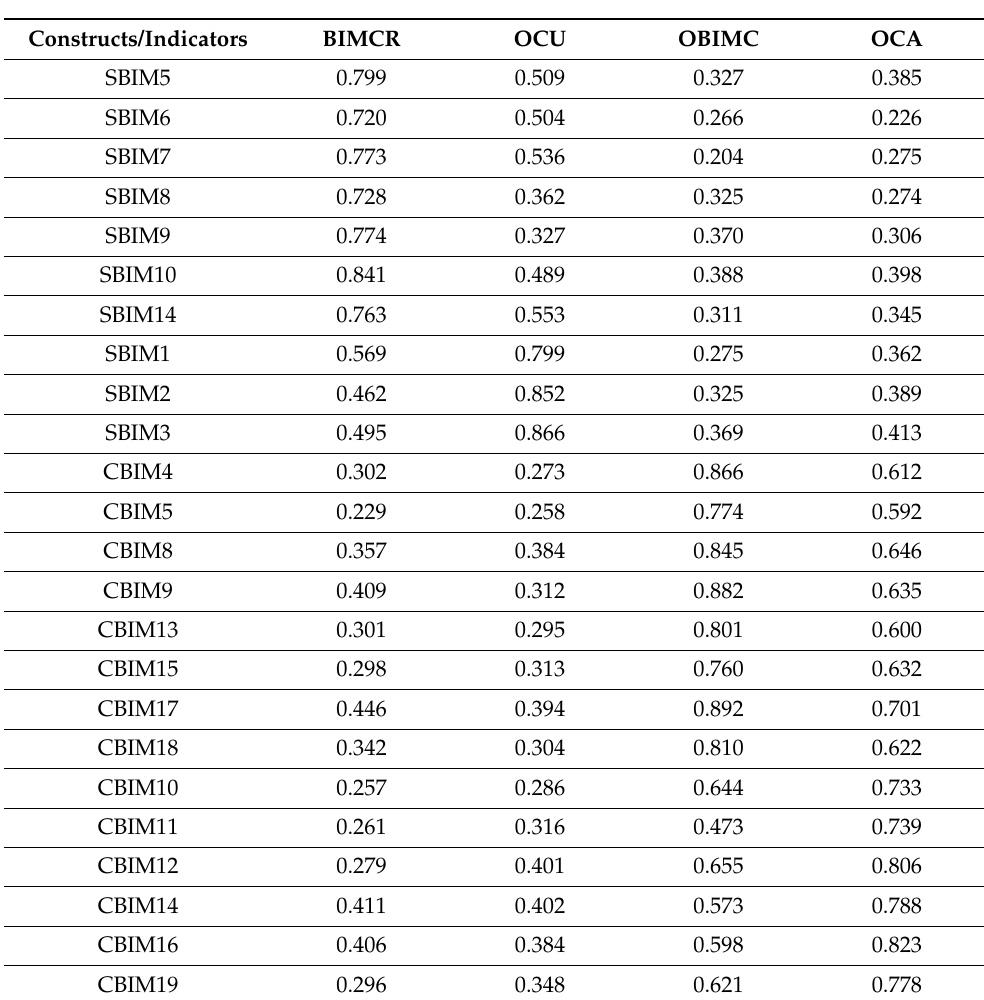
Figure 1. Measurement model. Table 7. Cross loadings.